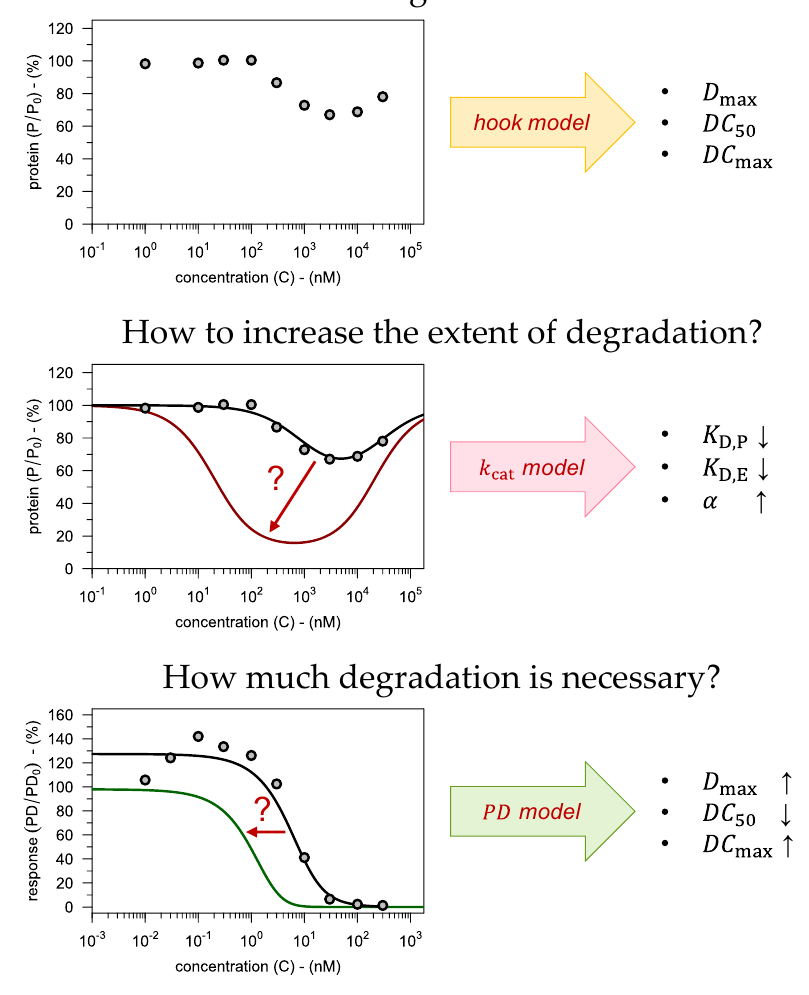
Figure 7. Our modeling framework can be used to address three major questions, each associated with one of the pillars of translational pharmacology (see Figures 1 and 2 for color coding). The hook model is fitted to the concentration-degradation profile yielding three parameters which can be used to assess PROTACs as degraders. The 𝑘 cat model allows to predict what binding affinities are necessary to achieve the desired degradation, thereby giving rational guidance to lead optimization efforts. The 𝑃𝐷 model translates protein degradation to a defined biomarker response. This is particularly useful when it comes to identifying a target value for protein degradation.